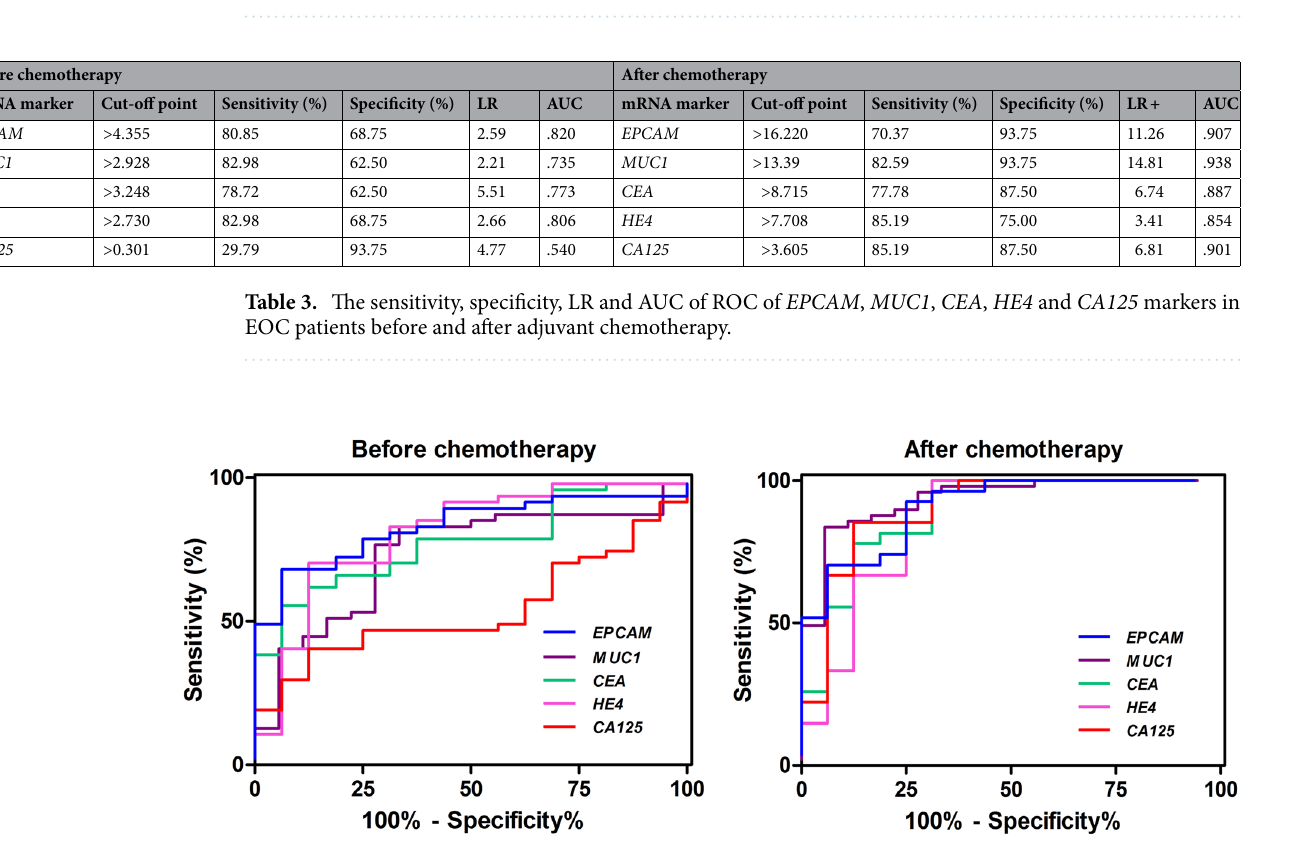
Figure 2. Relative expression levels of ( A ) EPCAM , ( B ) MUC1 , ( C ) CEA , ( D ) HE4 and ( E ) CA125 mRNAs in EOC patients before and after adjuvant chemotherapy. ( F ) Concomitant detection of HE4 mRNA before and after chemotherapy is associated with higher levels of serum CA125 antigen (measured before chemotherapy) (*: p < 0.05, **: p < 0.01).